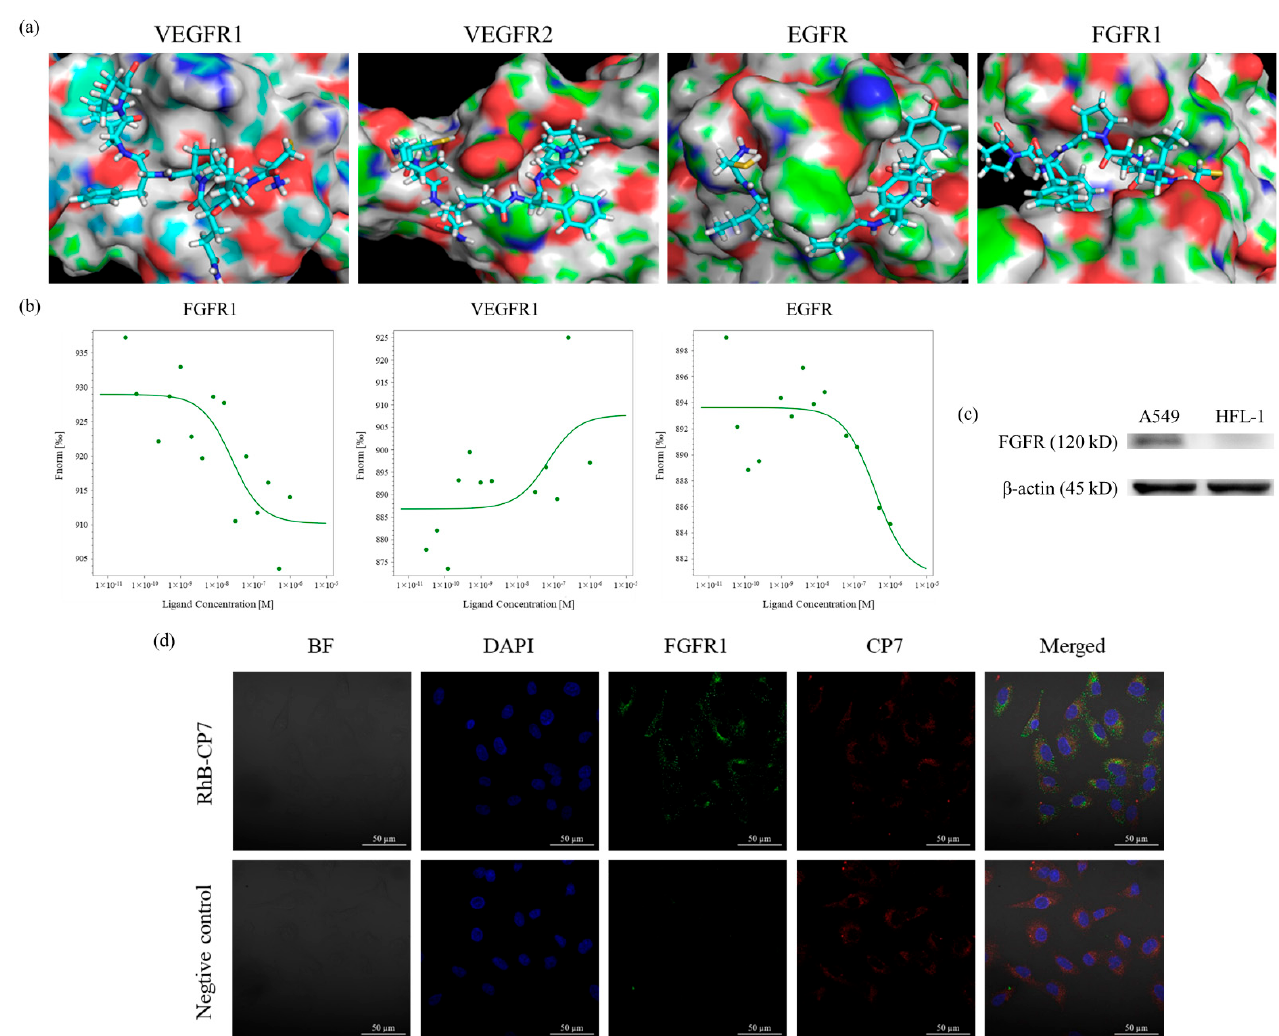
Figure 1. ( a ) Visualization of binding modes within active sites of VEGFR1, VEGFR2, EGFR, and FGFR1. CP7 is shown in stick representation in the binding pocket of selected targets, and proteins are represented using surface model. ( b ) Interaction between CP7, FGFR1, VEGFR1, and EGFR detected by MST. ( c ) Level of FGFR1 protein expressed in A549 and HFL-1 cells determined with Western blot technique. ( d ) Immunofluorescence colocalization of CP-7 peptide with an antibody specific for FGFR1. Scale bar = 50 μ m.